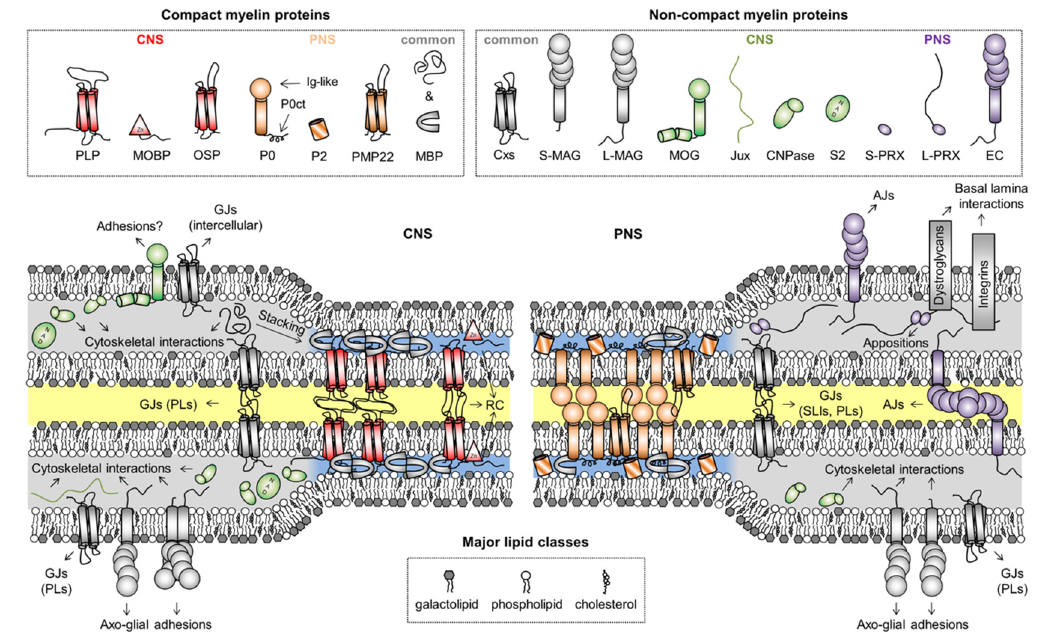
Figure 2. Myelin proteins and their compartmentalization. Some proteins are shared between CNS and PNS myelin, but their expression levels can vary drastically between the two, like in the case of CNPase, which is predominantly a CNS enzyme. The intracellular compartment is colored blue and gray for compact and non-compact myelin, respectively. The extracellular and intramyelinic compartments are colored white and yellow, respectively. Note that cytoskeletal elements, other common proteins, and cell organelles are not included for clarity. Abbreviations: AJs, adherens junctions; CNPase, 2 ′ ,3 ′ -cyclic nucleotide 3 ′ -phosphodiesterase; Cxs, connexins; EC, epithelial cadherin; GJs, gap junctions; Ig-like, immunoglobulin-like; Jux, juxtanodin; LIs, longitudal incisures; MAG, myelin-associated glycoprotein; MBP, myelin basic protein; MOBP, myelin-associated oligodendrocytic basic protein; MOG, myelin/oligodendrocyte glycoprotein; OSP, oligodendrocyte-specific protein/claudin 11; P0, myelin protein zero; P0ct, the cytoplasmic domain of P0; P2, peripheral myelin protein 2; PLP, proteolipid protein; PLs, paranodal loops; PMP22, peripheral myelin protein 22; PRX, periaxin; RC, radial component; S2, sirtuin 2; SLIs, Schmidt–Lanterman incisures. In MAG and PRX, the L- and S- prefixes indicate long and short isoforms, respectively.